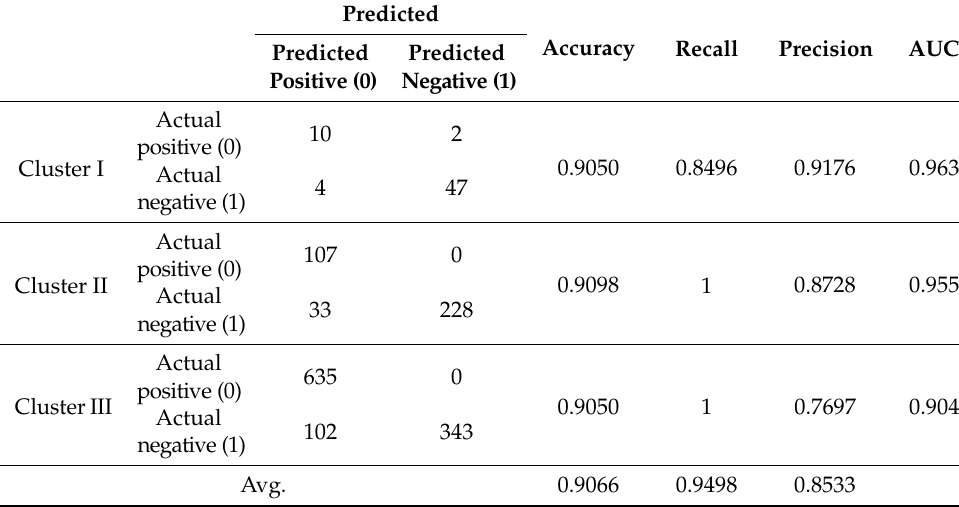
Table 8. LR confusion matrix after